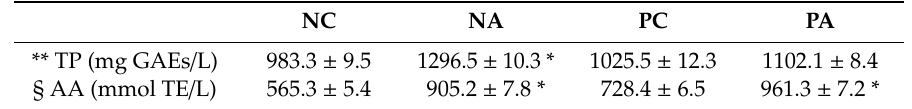
Table 4. Comparison of Total Phenolics content (TP) and Antioxidant Activity (AA) in Negramaro (NC and NA) and Primitivo wine extracts (PC and PA). Values reported in the table are the mean SD of three